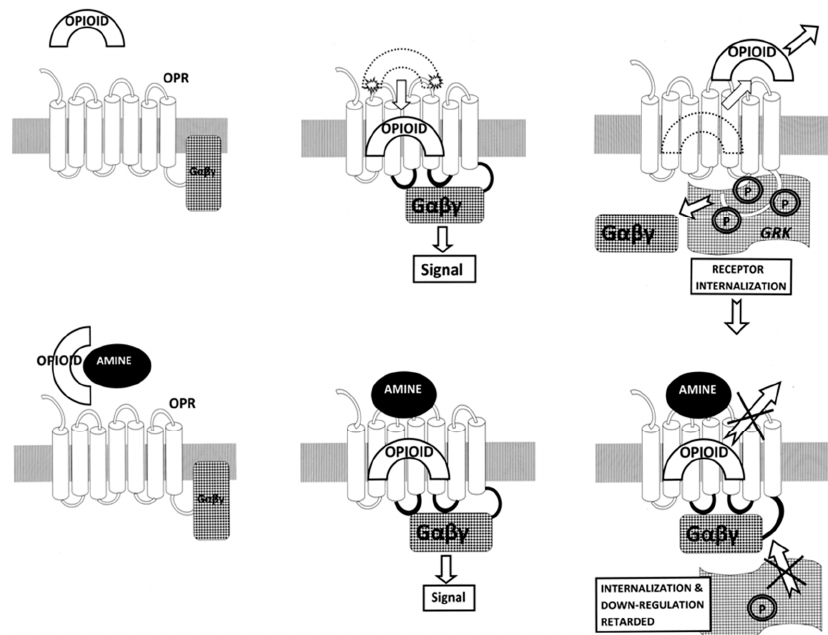
Figure 22. Schematic representation of opioid receptor (OPR) function in the absence and presence of an adrenergic enhancer. Top row from left to right: In the absence of an adrenergic enhancer, an opioid ligand is attracted to the opioid receptor; our data suggest that initial binding to the receptor is to a low-affinity, semi-specific site on the first and second extracellular loops [83], after which the opioid is drawn into the high-affinity, high-specificity cavity formed within the transmembrane loops [85]; high-affinity binding initiates G-protein coupling (G αβγ ) to the intracellular loops of the receptor, followed by the release of the ligand, phosphorylation (P) of the receptor by receptor kinases (GRK), receptor inactivation and internalization. Bottom row from left to right: In the presence of an adrenergic (or possibly serotoninergic) enhancer (“amine”), the same series of steps occur as in the top row, except that the enhancer binds to the extracellular loops after opioid high affinity binding, either “capping and trapping” the ligand in the receptor and/or maintaining the receptor in its high-affinity state for the ligand. In either case, the opioid ligand is not released as quickly from the receptor, preventing the allosteric alterations required for kinase phosphorylation and inactivation of the receptor. The overall effect of enhancer binding is therefore to keep receptor signaling “on” for a longer period of time than occurs in its